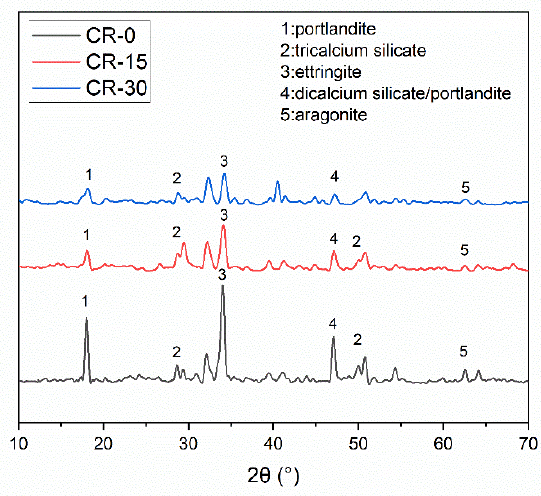
Figure 6. XRD patterns of resin-modified cement slurry.